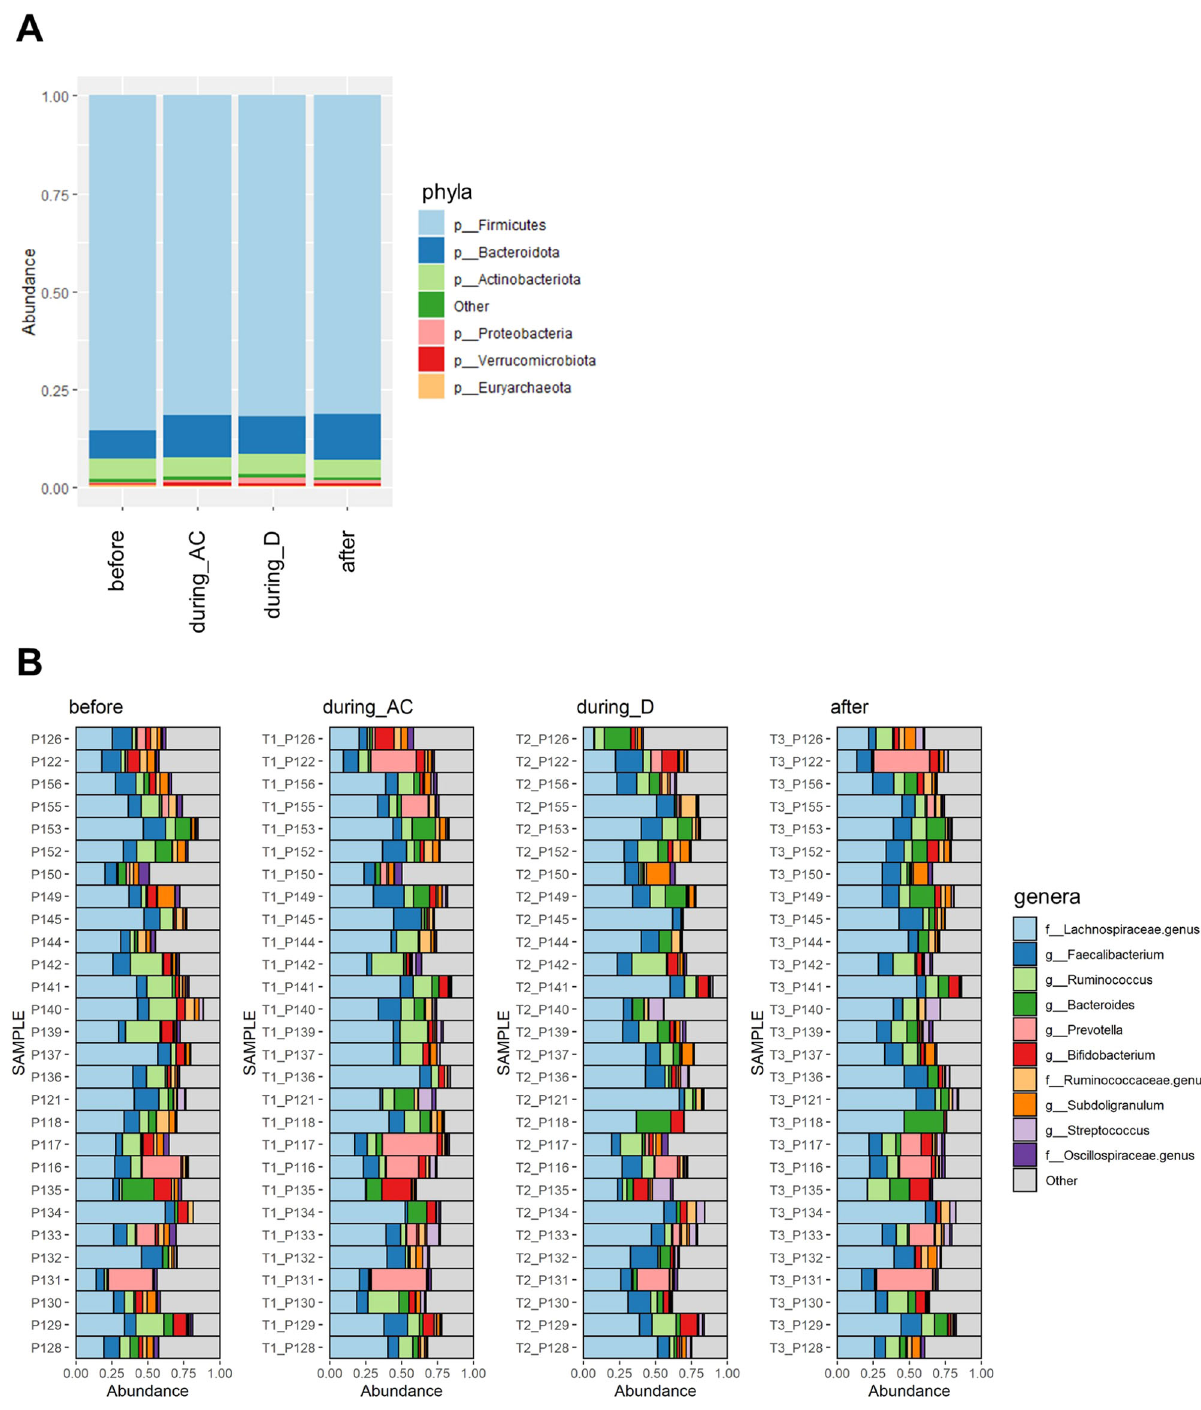
Fig. 2 Relative abundances of microbiota before, during and after chemotherapy. A Relative abundances of different phyla before AC-D ( n = 44), during AC ( n = 43), during D ( n = 29) and after AC-D treatment ( n = 37). B Composition plot of individual samples (of participants who provided all four samples, n = 28) indicating changes in the relative abundance of most common genera over the course of AC-D